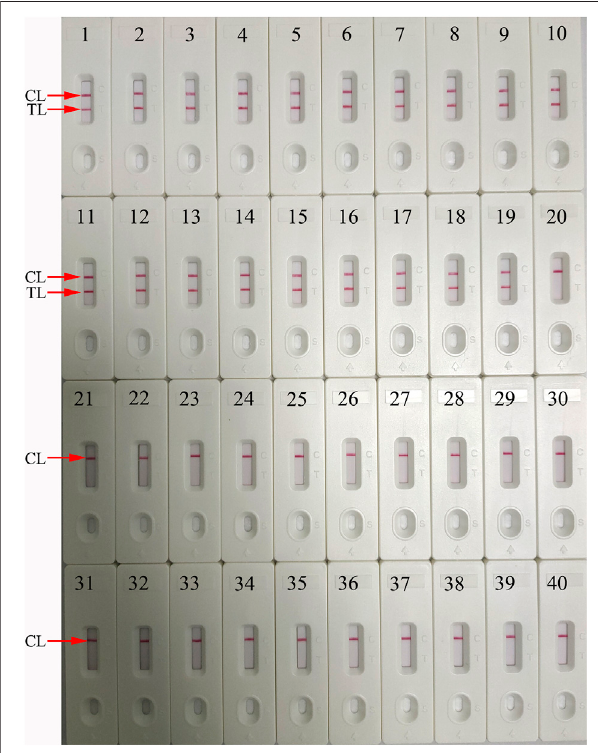
FIGURE 7 | Analytical specificity of the N. gonorrhoeae -LAMP-PNB assay using different pathogens. The N. gonorrhoeae -LAMP-PNB assay was veri fi ed using different genomic RNA/DNA as templates. Biosensor 1, N. gonorrhoeae (ATCC 49926); Biosensor 2 – 19, N. gonorrhoeae (clinical samples); Biosensor 20, Chlamydia trachomatis ; Biosensor 21, Neisseria meningitidis ; Biosensor 22, Pseudomonas aeruginosa ; Biosensor 23,